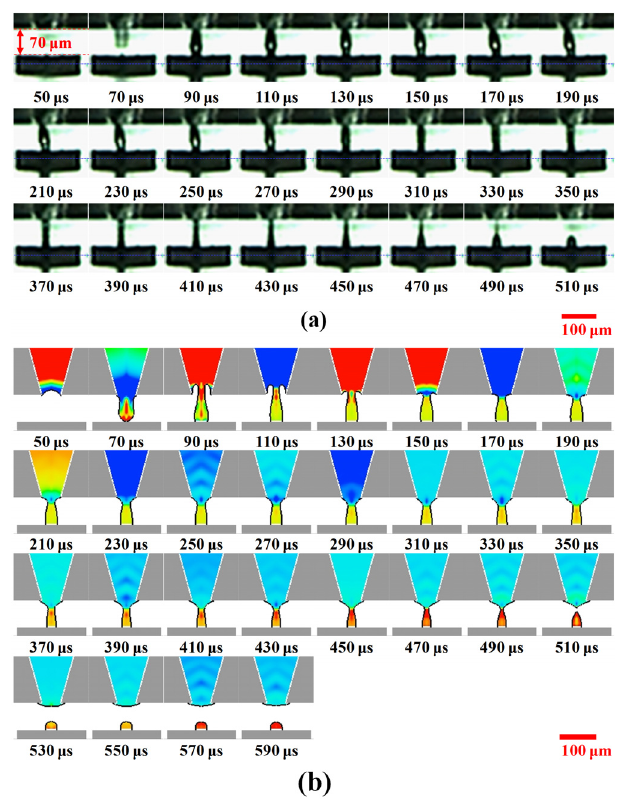
Figure 7. Evolution of dispensing process for gap of 70 μ m. ( a ) Experimental observations and ( b ) Simulation results.